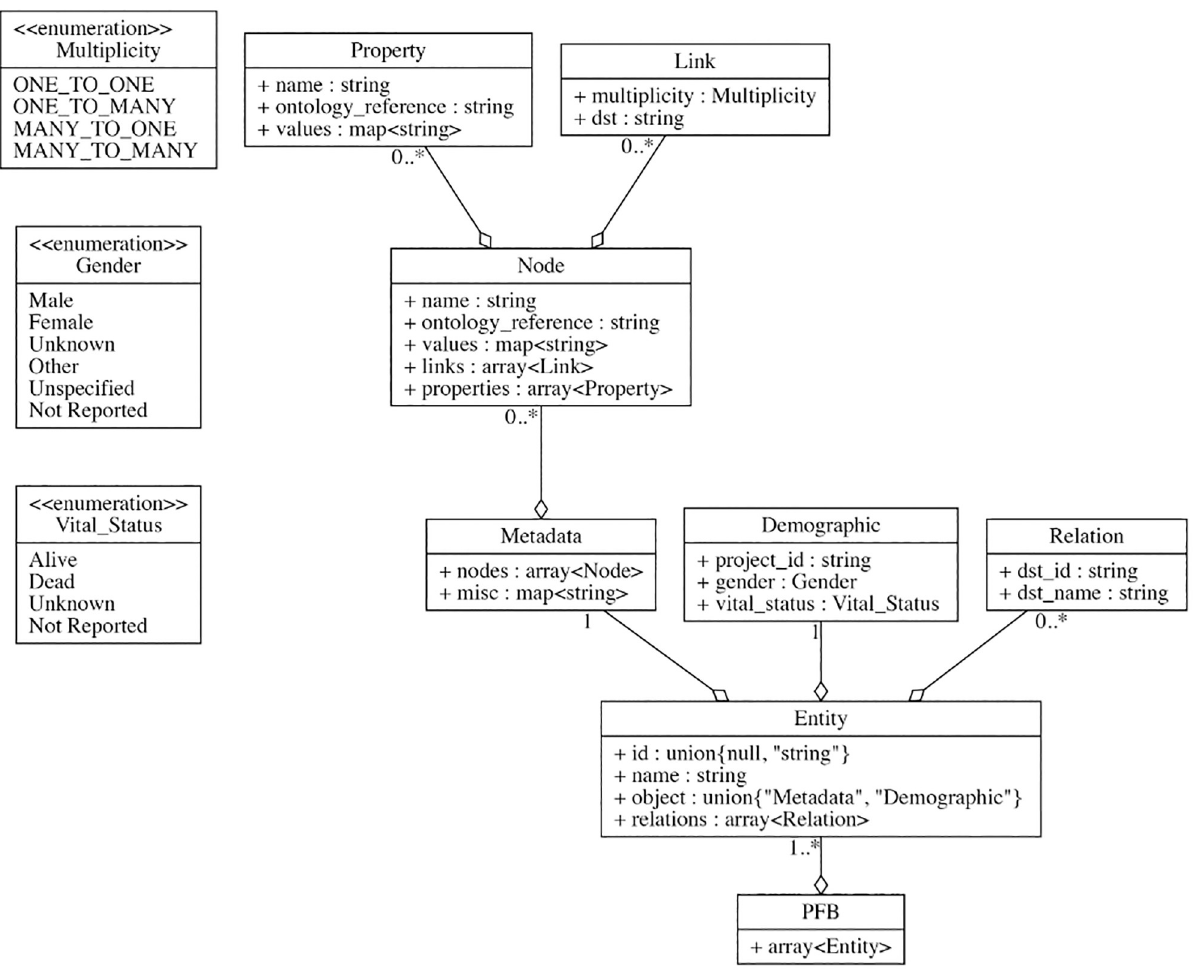
Fig 2. The graphical representation of PFB schema for a data model with only a Demographic